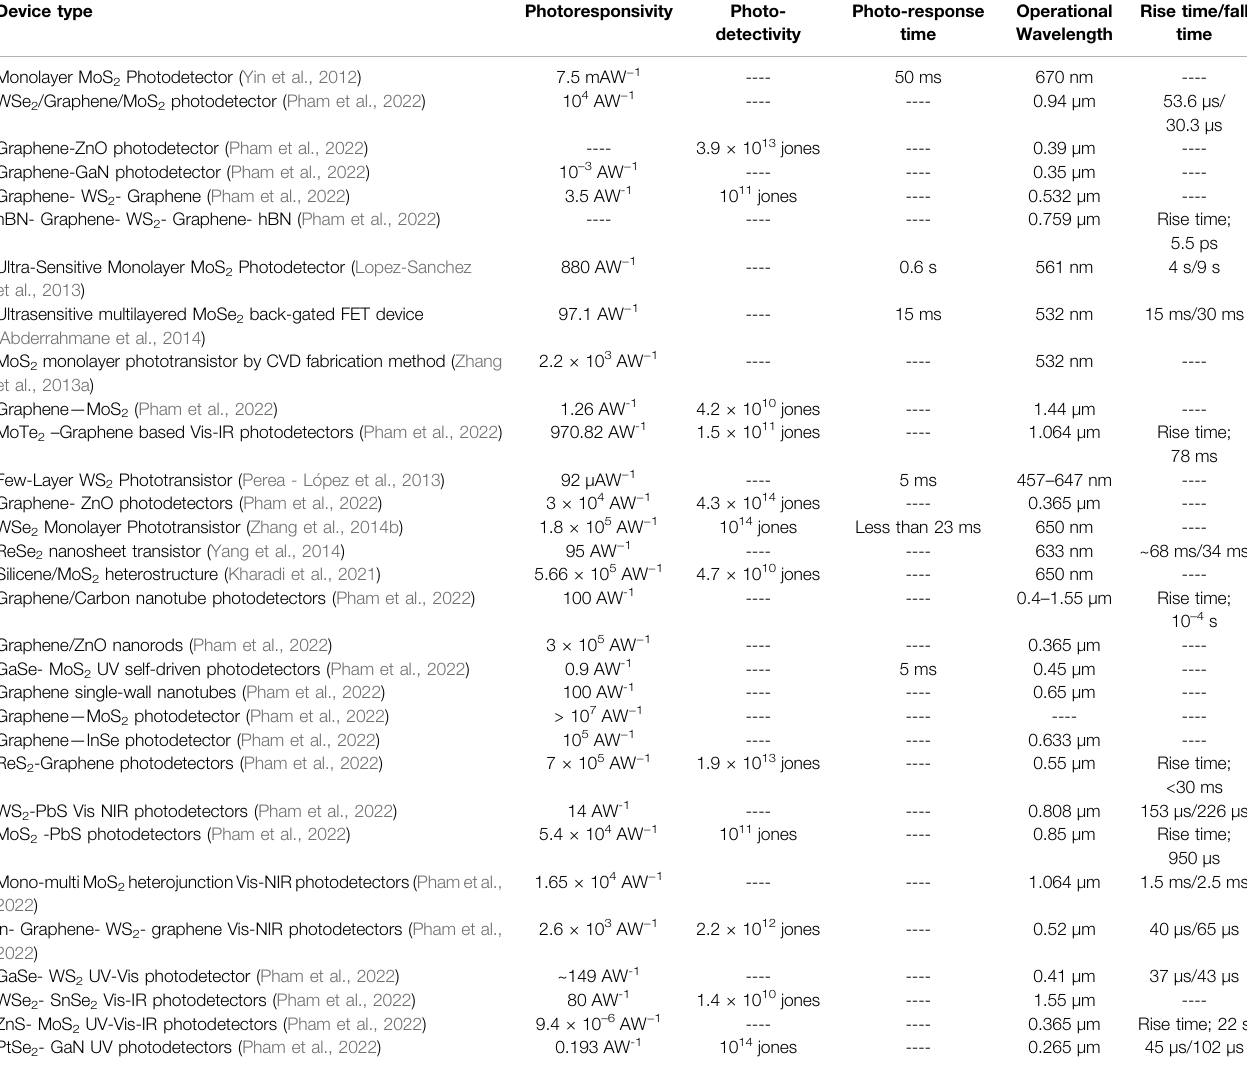
TABLE 1 | Performance yield of photodetectors based on different 2D